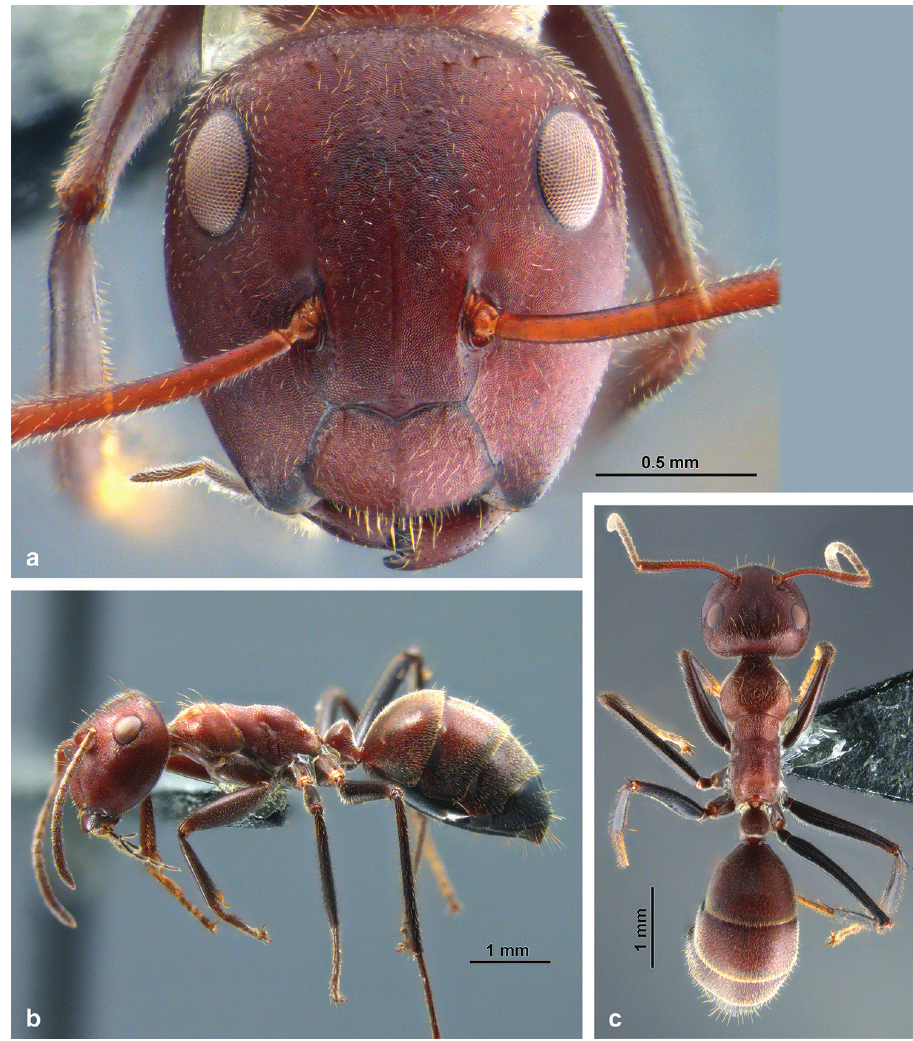
Figure 2. Habitus of C. explodens sp. n., holotype, minor worker; a full-face b lateral, and c dorsal view. very fine, isodiametric or transverse mesh-like reticules; intermixed punctures very fine and inconspicuous on face, larger but shallow laterally and ventrally. Eyes small compared to other castes (EI 27–29, vs. 28–31 in major workers and 35–37 in gynes), flat, posi- tioned dorsolaterally. Ocelli lacking, in some larger specimens position of median ocellus indicated by shallow impression. Frons with very fine impressed midline; frontal carinae slightly converging anteriorly, not elevated. Median carina of clypeus not reaching ante- rior clypeal margin, especially in small specimens. Mandibles mostly smooth, with rather dense punctures; masticatory margin with five teeth. Maxillary palpi long (PSI 28–35). Antennal scape long, its length roughly equal to head width (SI 87–104),